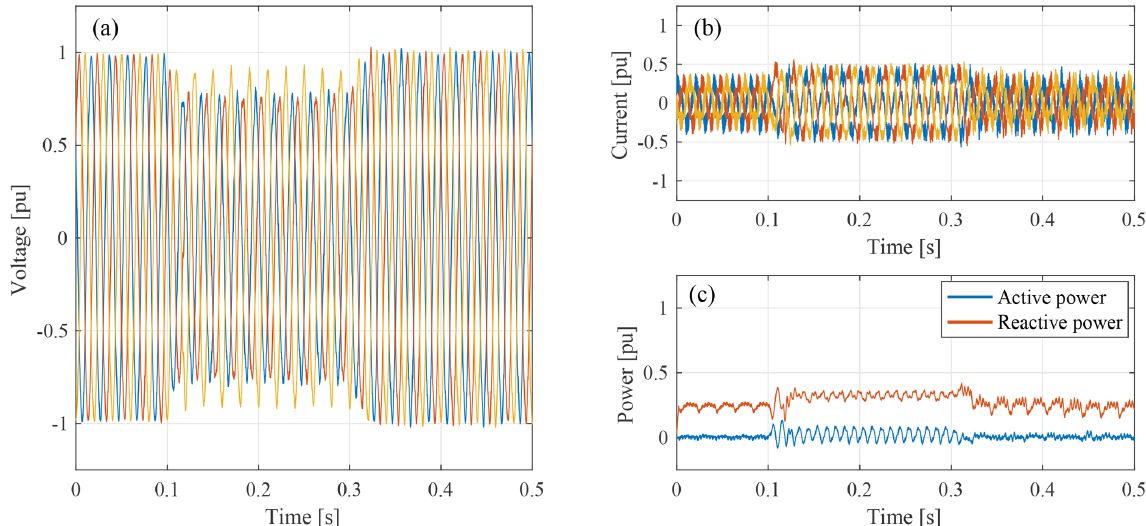
Figure 8. Wind turbine tested for unbalanced voltage dip at low power production: three-phase voltage (a) , current (b) and active and reactive power output (c)